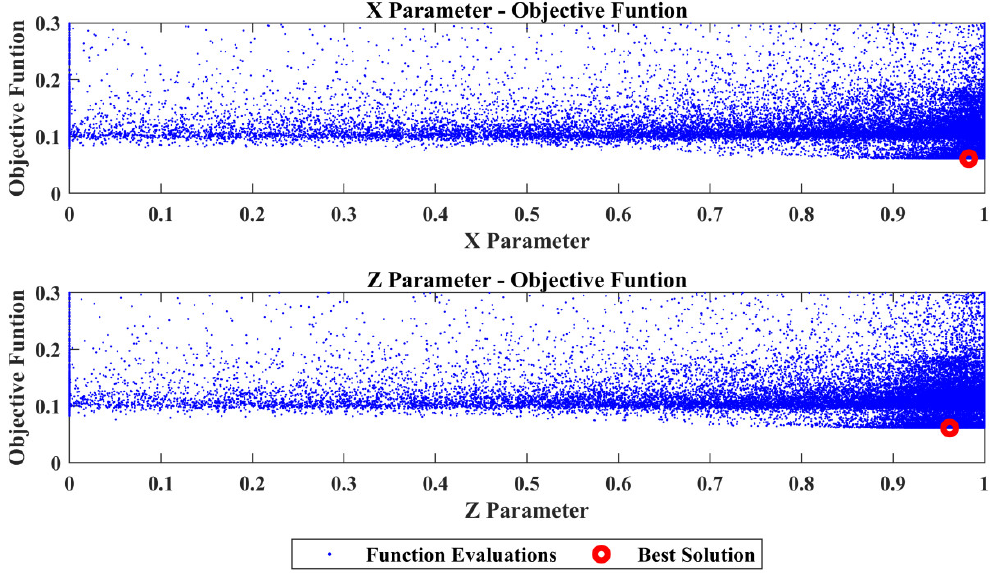
Figure 11. Case 1: X and Z parameters versus the Objective Function values.